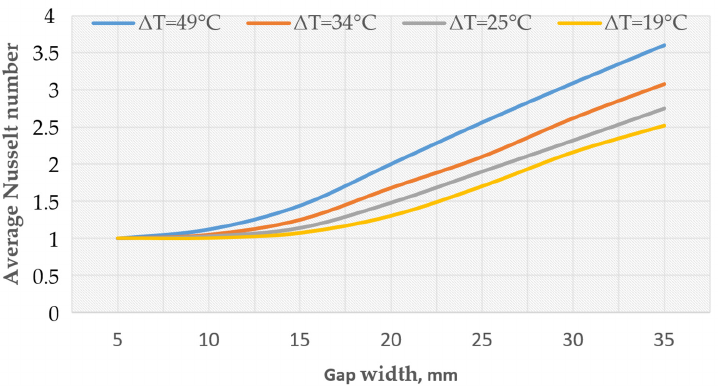
Figure 1. Impact of gap width on the average Nusselt number at the inner pane (summarized data from cited papers). Figure 1 indicates that for smaller values of air layer thickness, average Nusselt num-